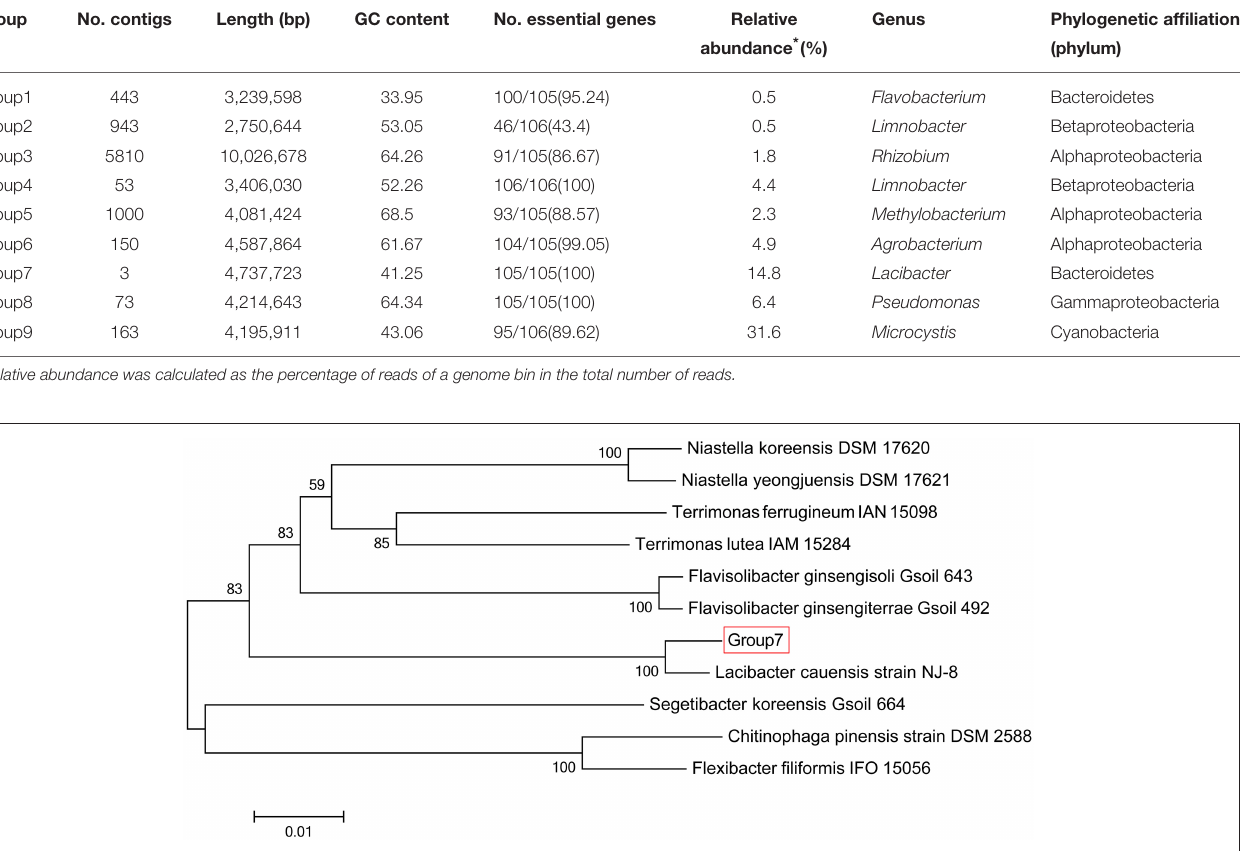
FIGURE 3 | Phylogenetic inference of Group 7 using 16S rRNA gene sequences. Neighbor-joining phylogenetic tree is constructed based on 16S rRNA gene sequences showing the position of Group 7 among related species. Numbers at nodes indicate bootstrap percentages (based on 1000 replicates); only values > 50% are shown. Bar, 0.01 substitutions per nucleotide